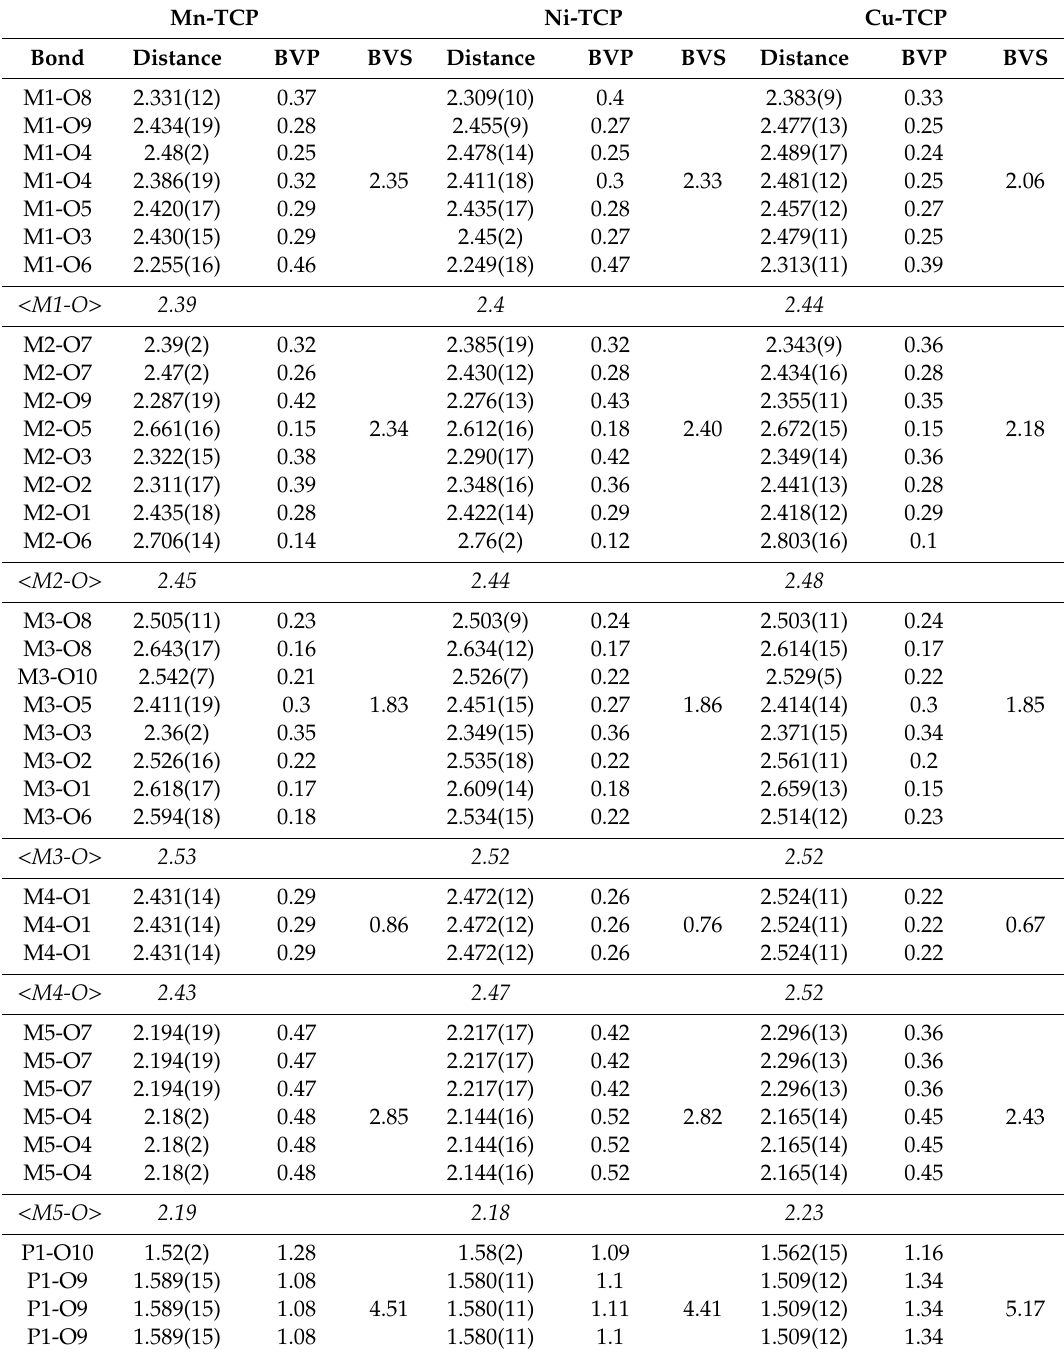
Table 4. Bond distances (Å) and bond valence parameters / sum (BVP / BVS, expressed in valence calculated according to the single cationic occupancies of the M5 site: Mn = 0.32(3)%, Ni = 0.31(2)%, Cu =